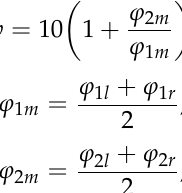
Figure 7. Dependence of the strain rate in direction of thickness on time. Subsequently, the number of points on the outer left and outer right sides of the curve were determined according to Equations (6)–(8), which were also filtered out and not included in the analysis (Figure 8). Evaluated values of major and minor strain are shown in Table 5.